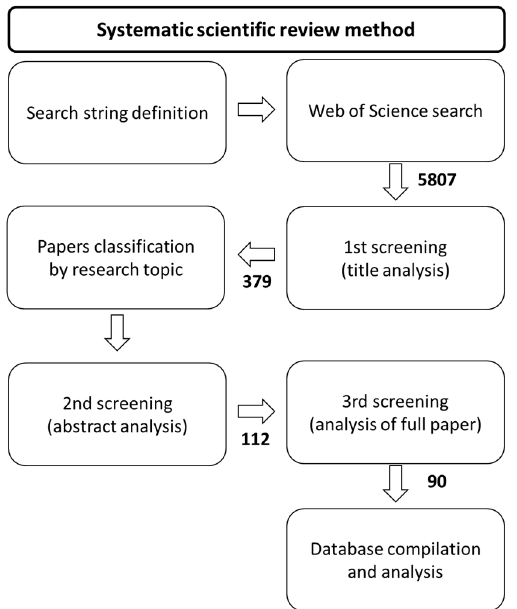
Figure 1. Main stages of the systematic review indicating the number of scientific papers processed on each stage. When unclear, papers were conditionally moved forward.